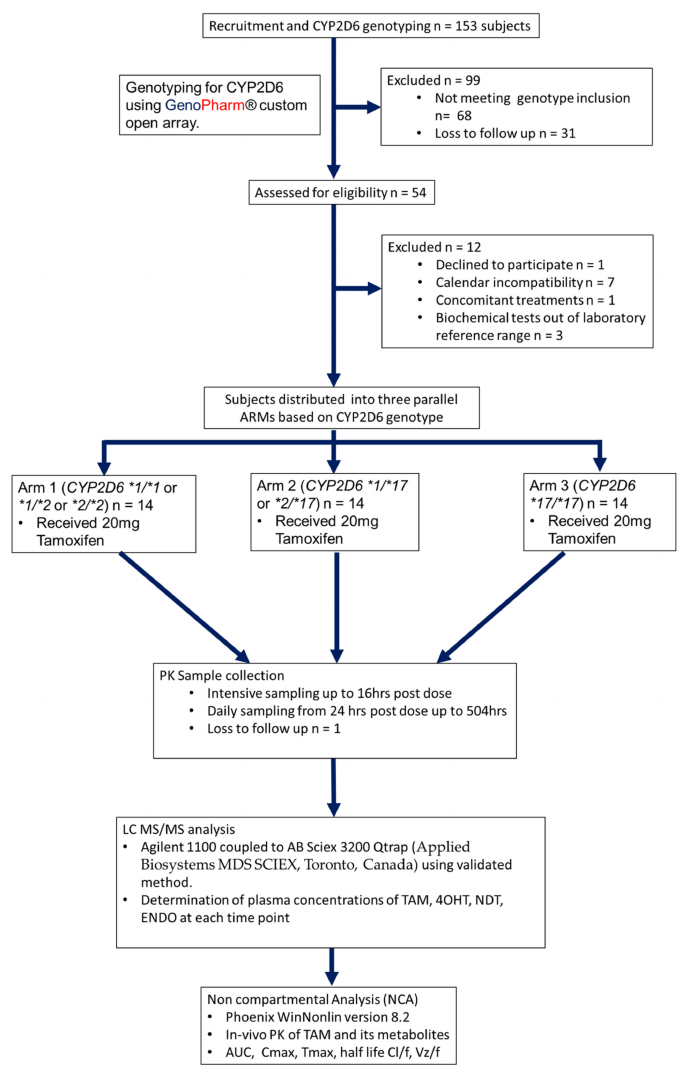
Figure 1. Study design and sequence flow chart for the pharmacokinetic study to determine the effect of CYP2D6*17 on the metabolism of TAM to ENDO. Table 1. Baseline characteristics of subjects enrolled in the